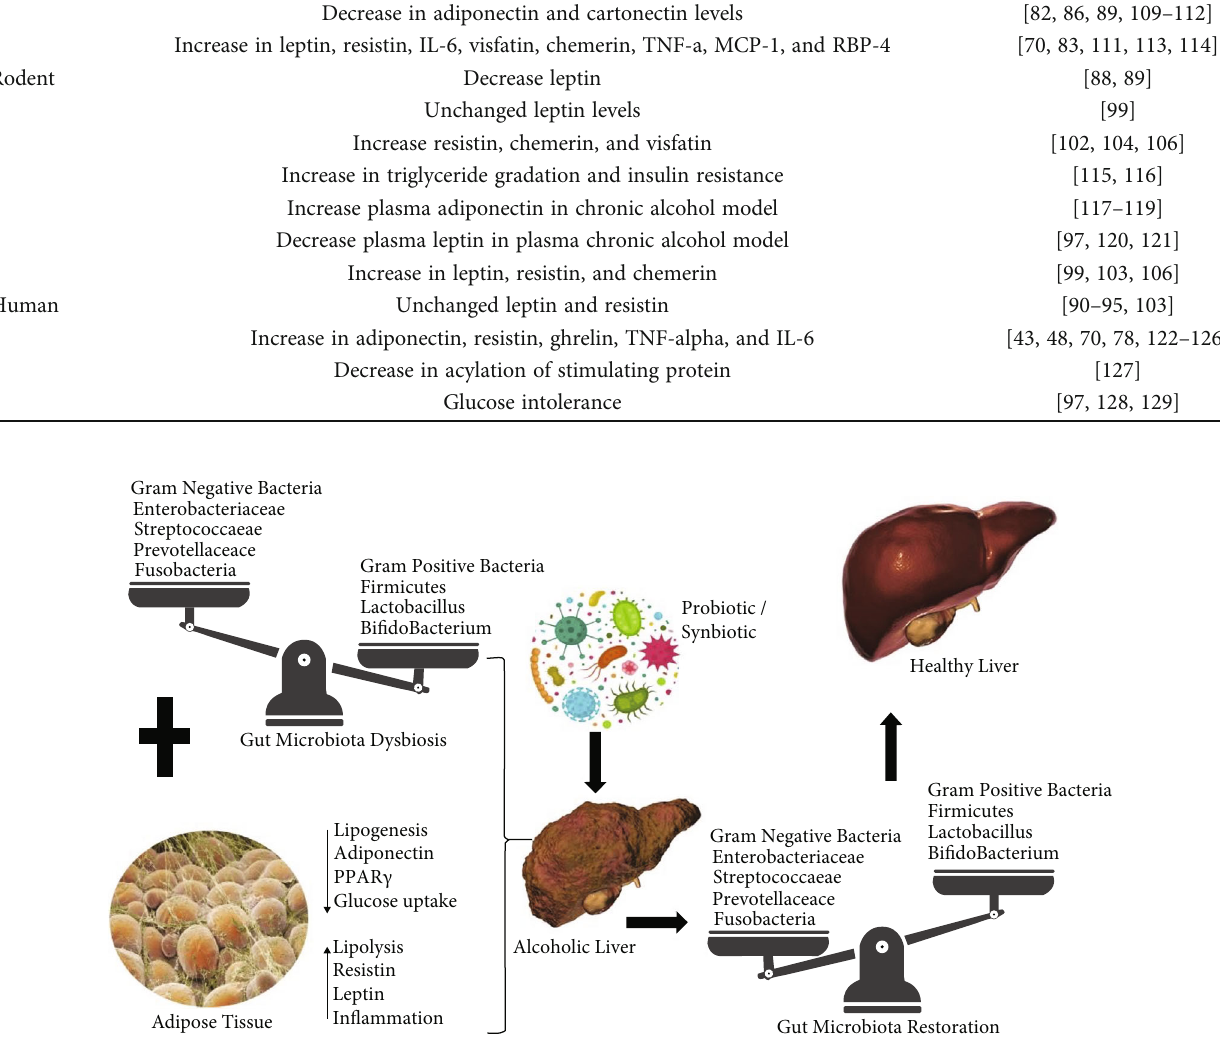
Figure 2: Possible treatment strategy to modify gut-adipose tissue-liver axis by the ingestion of probiotic and symbiotic leading to the restoration of gut